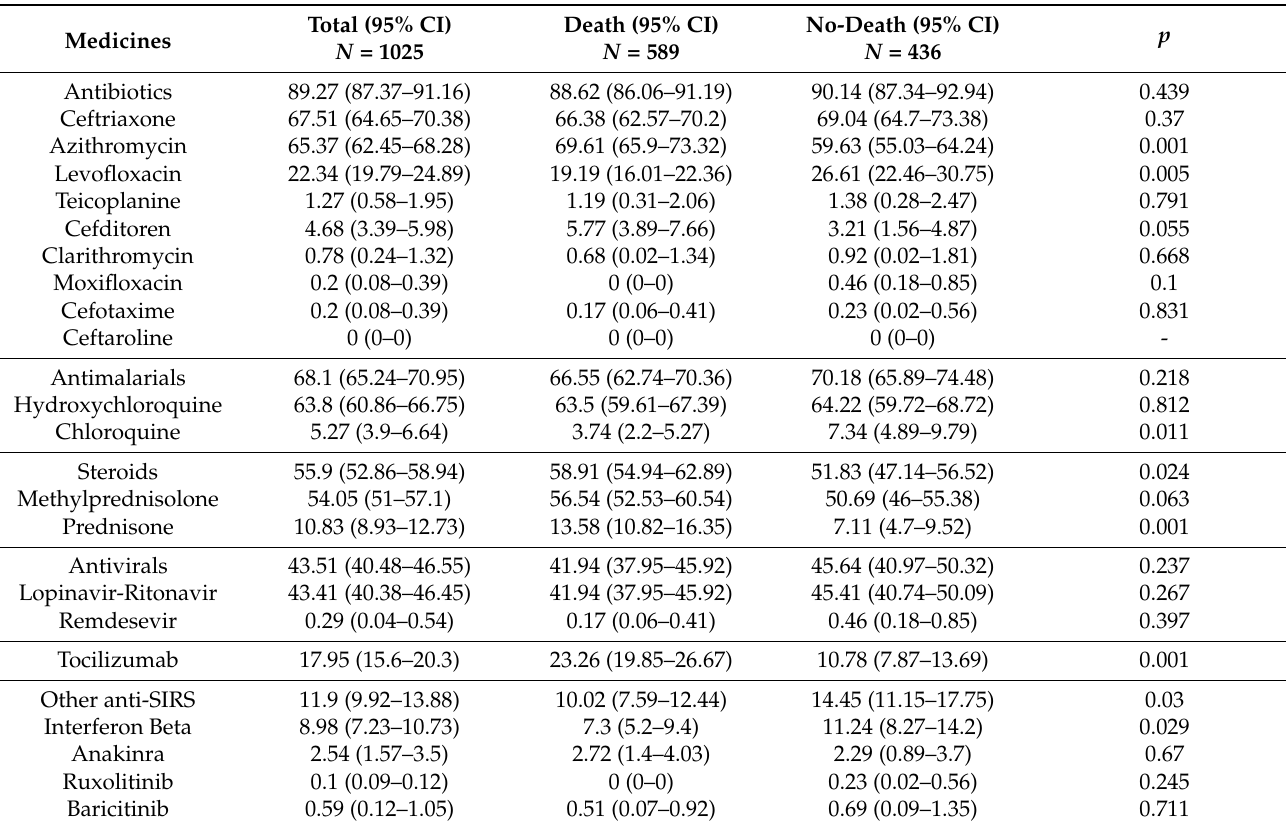
Table 3. Medicines used by in-hospital COVID-19 patients with severe acute respiratory syndrome in Castile and Leon (Spain) (1 March–31 May 2020).